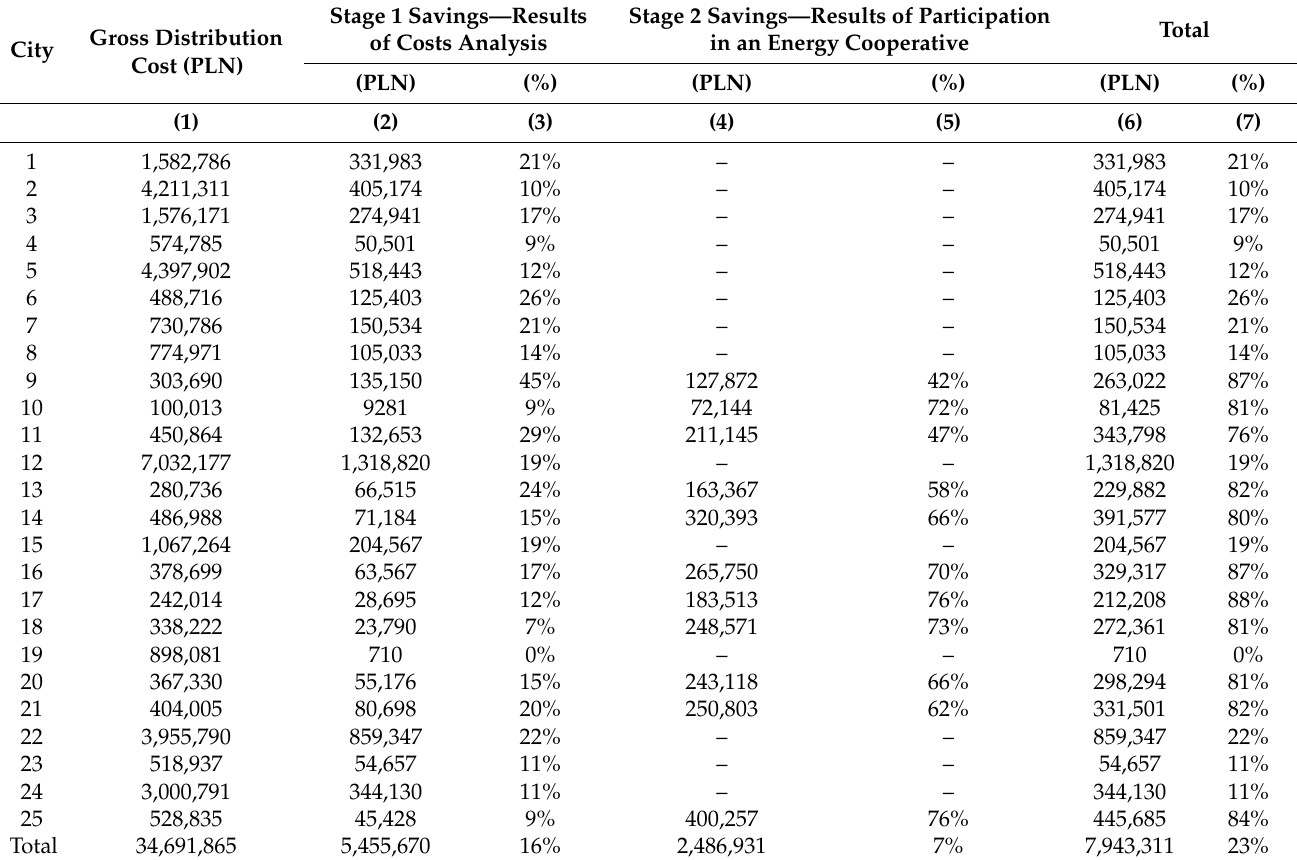
Table 5. Electricity distribution costs analysis including participation in an energy